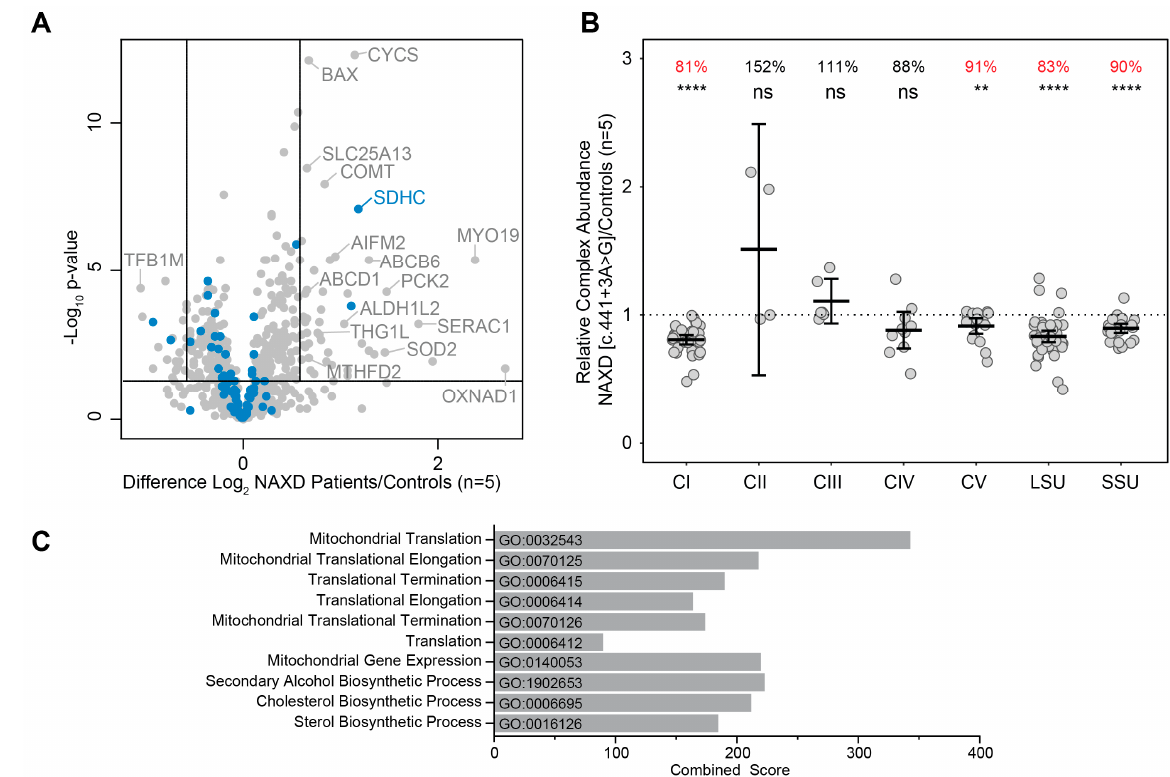
Figure 3. Fibroblast proteomic analysis of the proband with the NAXD c.441+3A>G variant. ( A ) Vol- cano plot showing protein abundances of mitochondrial proteins (based on MitoCarta3.0 annotations) detected through quantitative proteomics in the fibroblasts from all five NAXD cases relative to healthy controls (n = 5). Horizontal line represents p = 0.05 and the vertical lines represent fold changes of ± 1.5. Blue = OXPHOS subunits. ( B ) Relative complex abundance (RCA) profiles from quantitative proteomics revealed a significant reduction in mitochondrial OXPHOS complex subunits (CI and CV) and mitoribosomal proteins (large subunit ‘LSU’ and small subunit ‘SSU’) in fibroblasts from the adult onset NAXD case against controls (n = 5). Individual protein subunits are represented by a single dot. Overall mean values of subunits within each complex, which have been normalised to mitochondrial content levels, are represented by the middle bar. Upper and lower bars represent 95% confidence intervals. The mean ratio of each complex is shown as a percentage value on the top of each group. ns; p > 0.05, **; p ≤ 0.01, ****; p ≤ 0.0001. ( C ) Gene ontology (GO) terms for top ten biological processes enriched in cellular proteins decreased in abundance ( p < 0.05, fold change -1.5) within three or more NAXD cases analysed by quantitative proteomics. Biological processes were determined by Enrichr [7,8] and ranked by adjusted p -value. The combined score, de- termined by multiplying the p -value and z-scores, is shown on the X-axis (full list in Supplementary Table S2). Table 1. Summary of quantitative proteomic analysis in fibroblasts from adult-onset and paediatric NAXD cases.